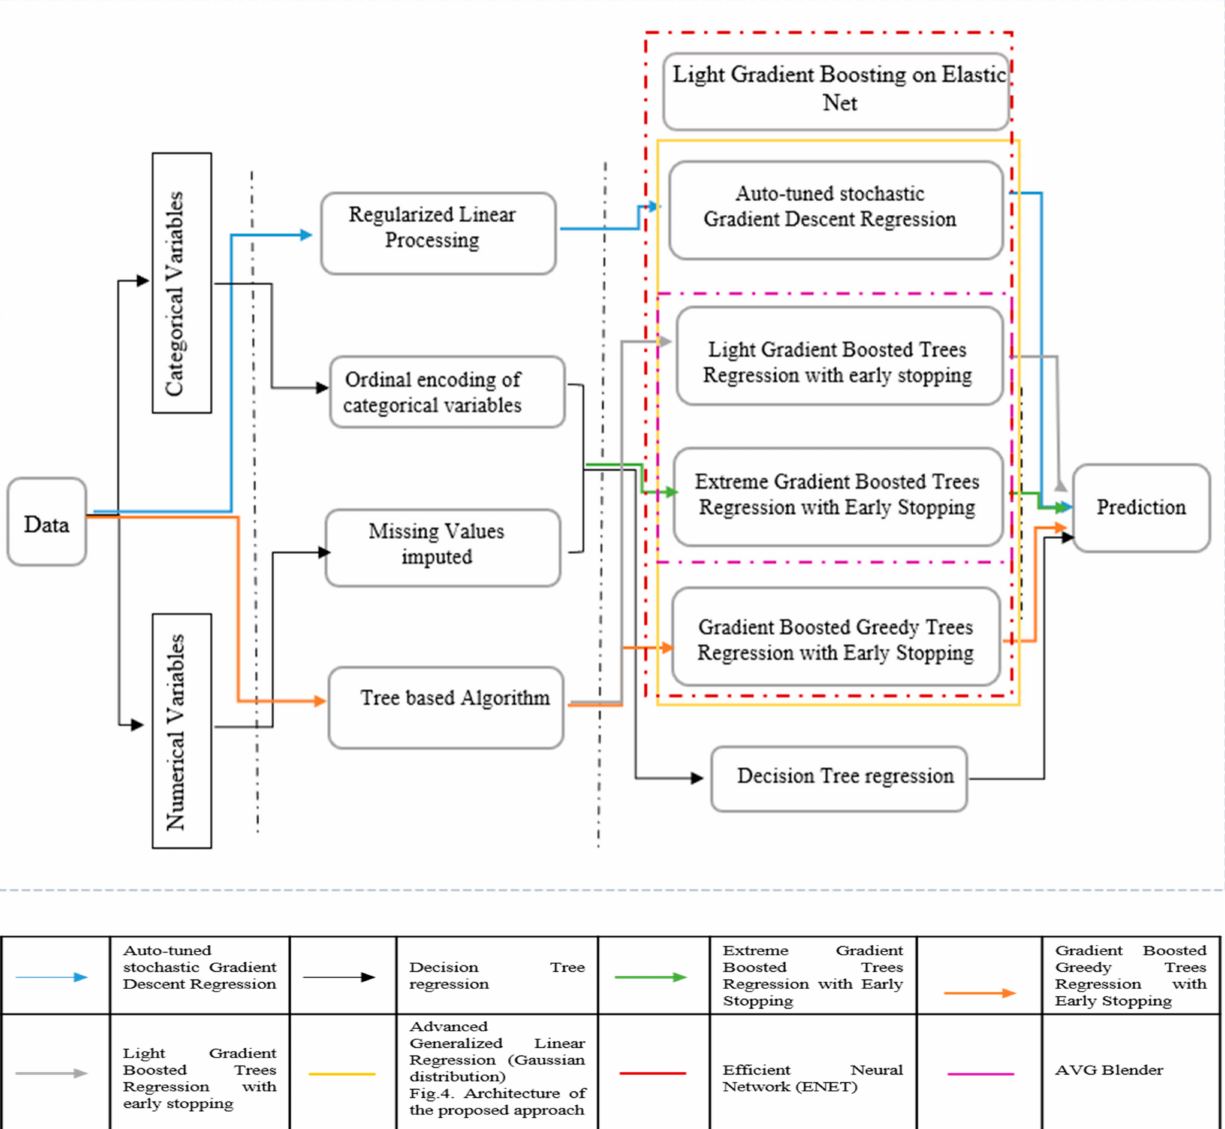
Figure 4 details the dynamics of the different algorithms used in our approach: